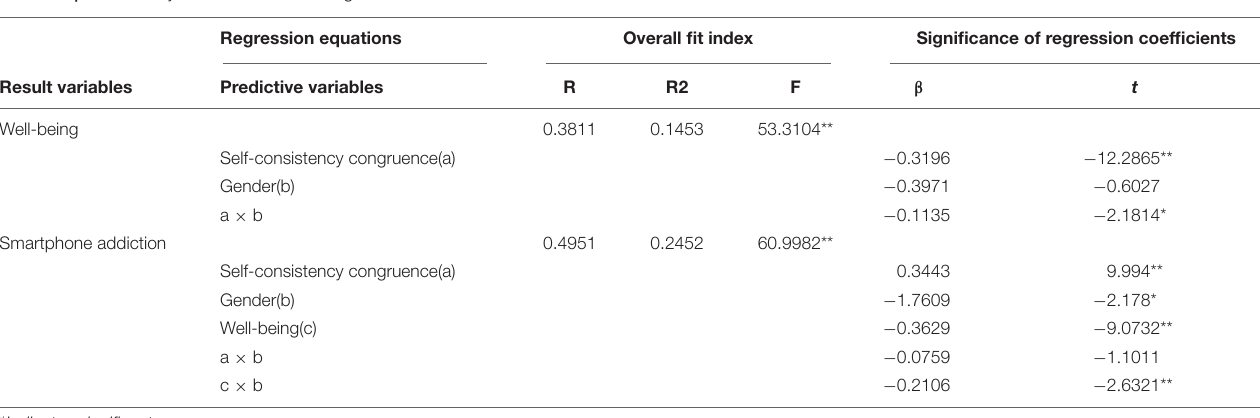
TABLE 3 | Intermediary model with moderating.